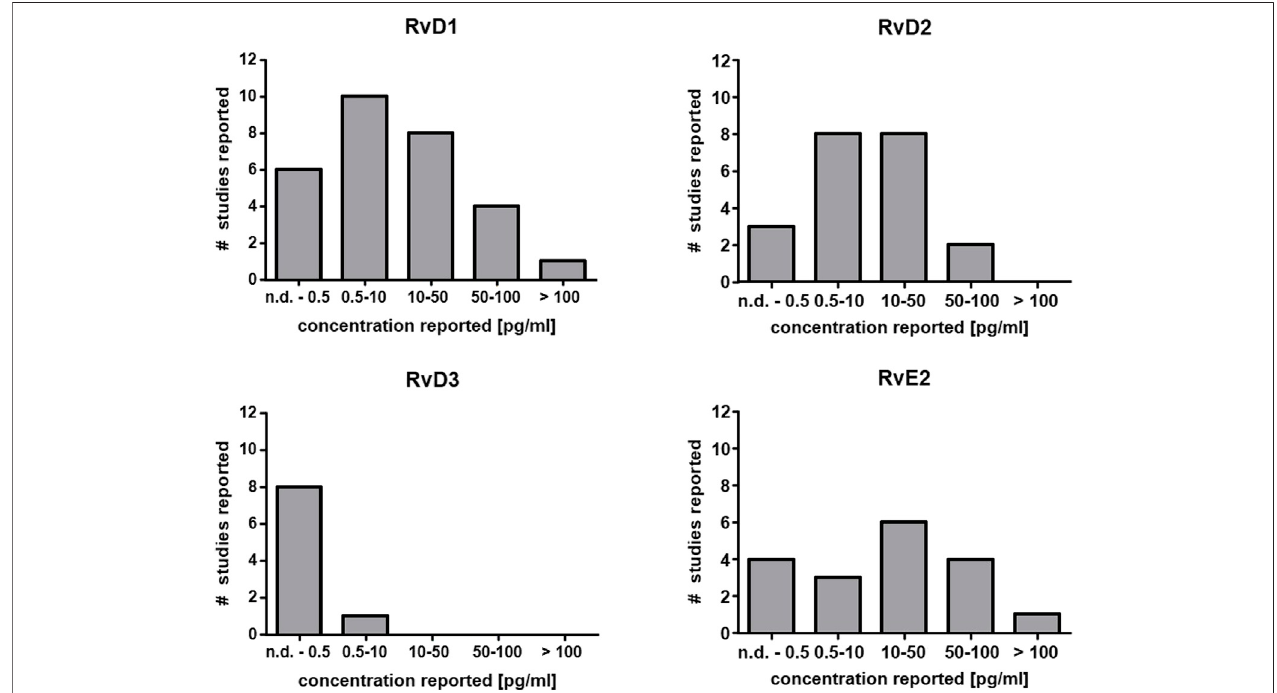
FIGURE 2 | Reported concentration ranges of selected SPMs in human plasma. Based on the comprehensive review from Calder (Calder, 2020) the number of studies and the detected concentration range are summarized for RvD1, RvD2, RvD3 and RvE2 in plasma from human subjects. In the majority of the studies the concentration is low ( < 50 pg/ml) which is close to the detection limit of several methods or below ( Table 2 ).